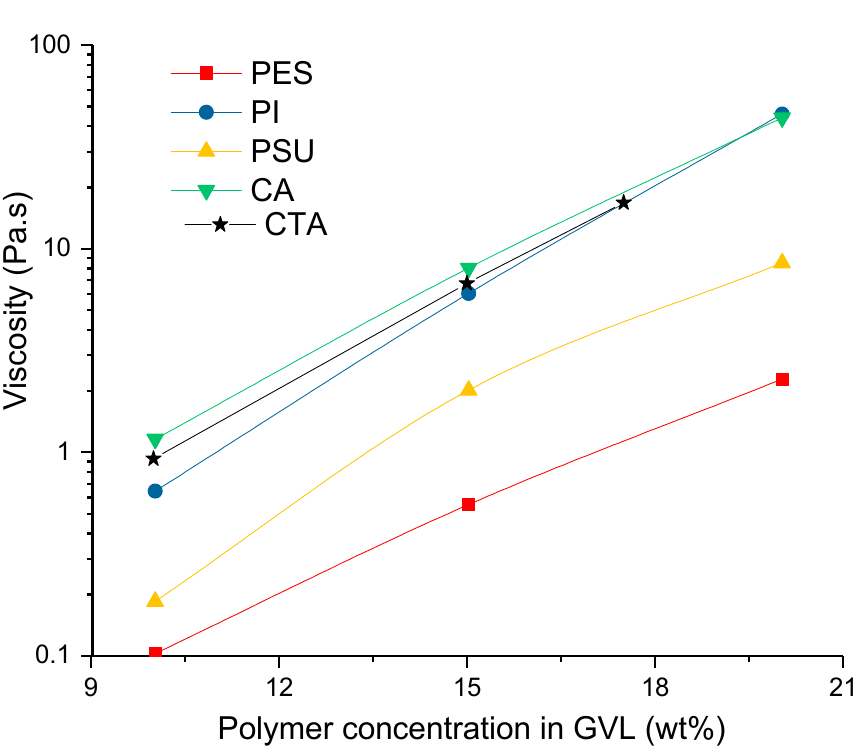
Figure 3. Influence of increasing polymer concentration on rheology of the casting solutions.